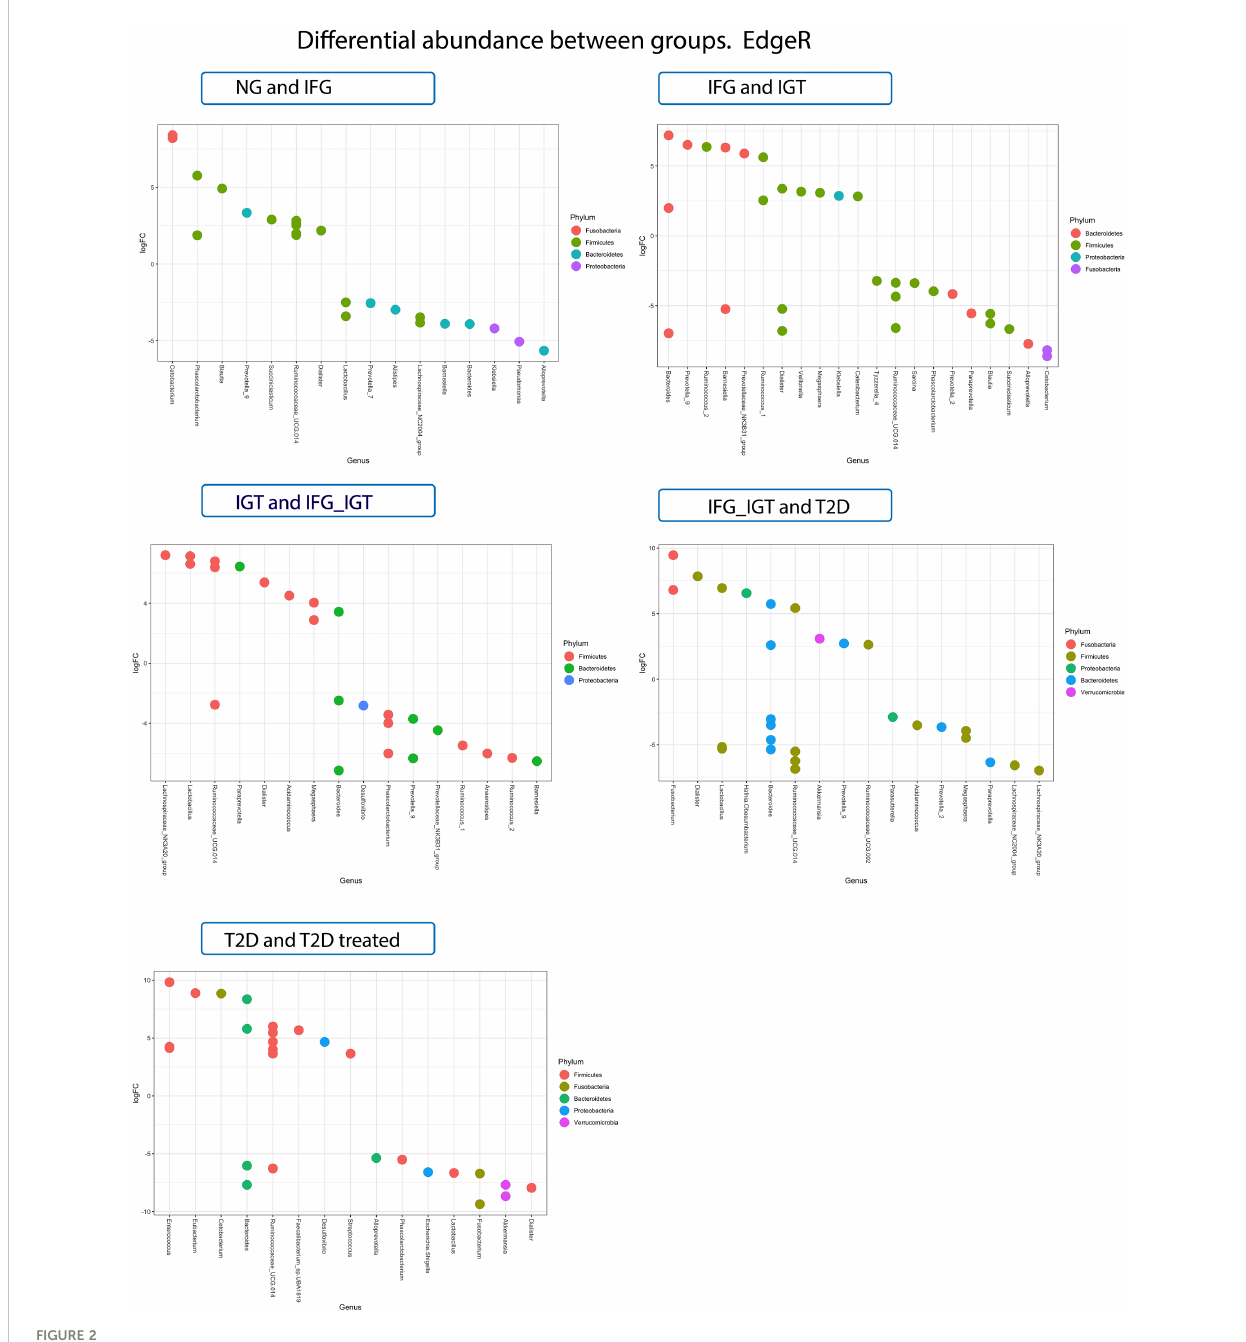
FIGURE 2 LogFC differential abundance (or coef fi cient from edgeR log-linear models for each comparison group and all signi fi cant ASVs) of GM data of Mexican T2D patients. Colors refer to the phyla taxonomy level of the plotted